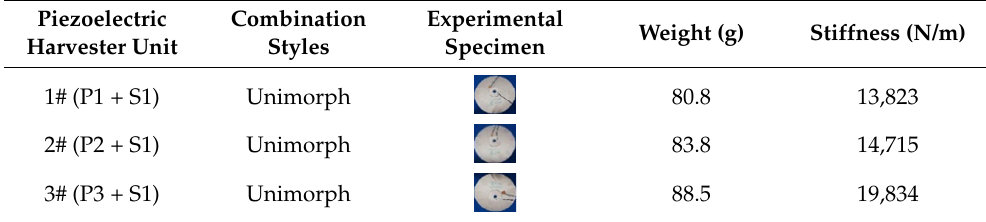
Table 3. Material properties of piezoelectric harvester units.